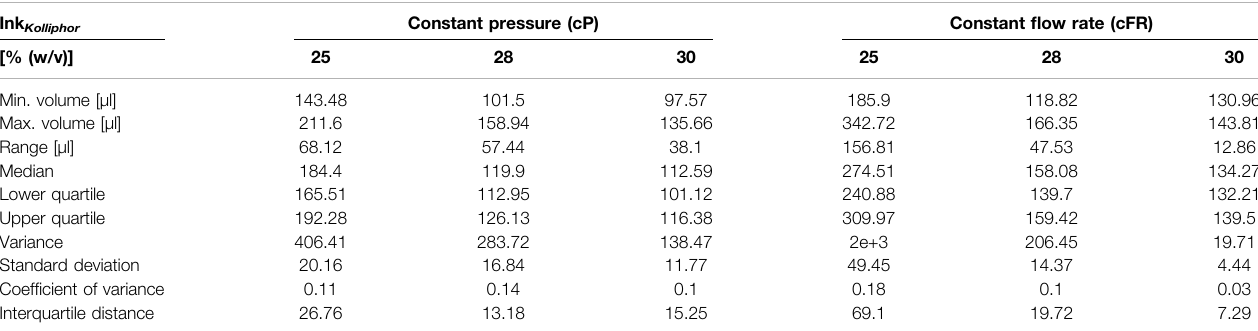
TABLE 6 | Boxplot key fi gures of Kolliphor containing inks boxplots shown in Figures 8A – C . Ink Kolliphor Constant pressure